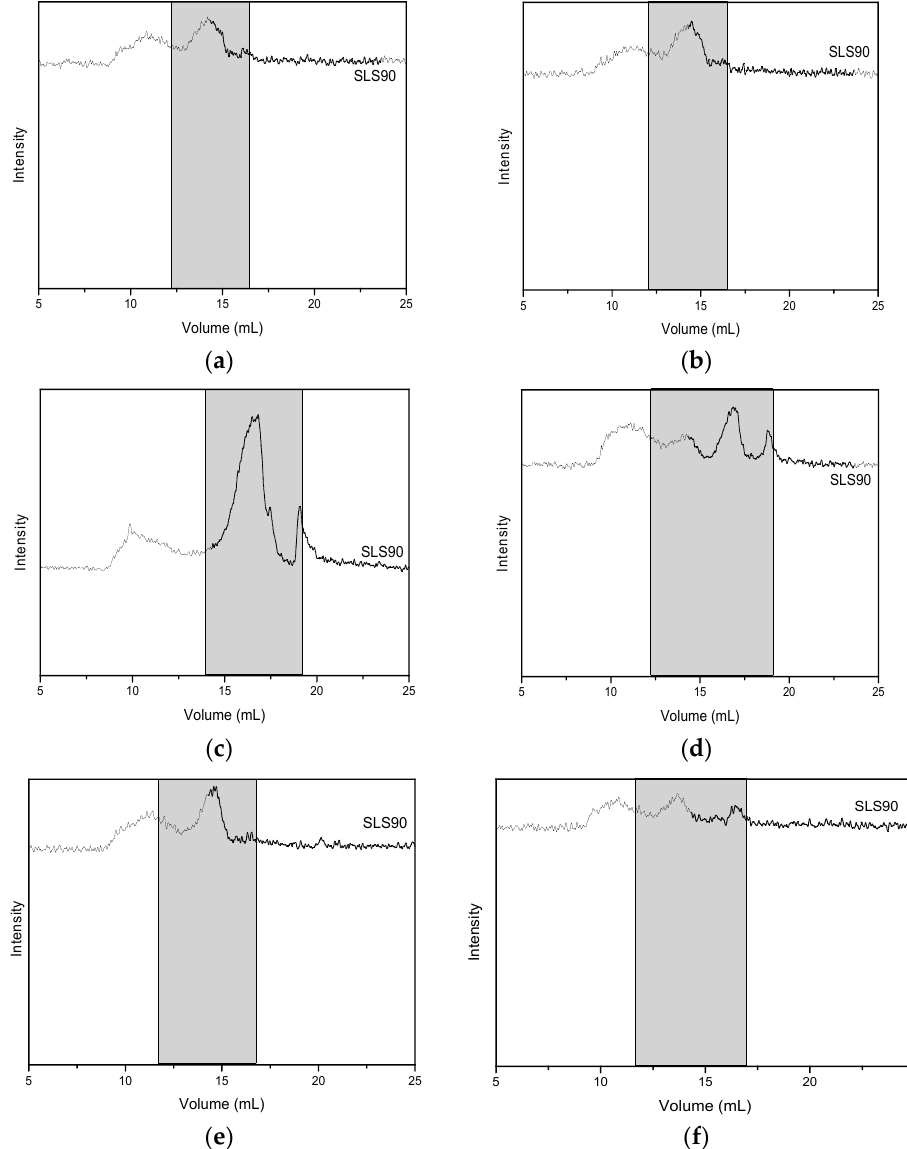
Figure 1. Size exclusion chromatograms of the extracts obtained from non-composted mixtures on the left column ( a , c , e ) and size exclusion chromatograms of the extracts obtained from partially composted mixtures on the right column ( b , d , f ). Top to bottom: Extracts obtained at pH 5 ( a , b ), pH 7 ( c , d ), and pH 9 ( e , f ). The greyed out areas highlight the regions of significant UV absorbance at 280